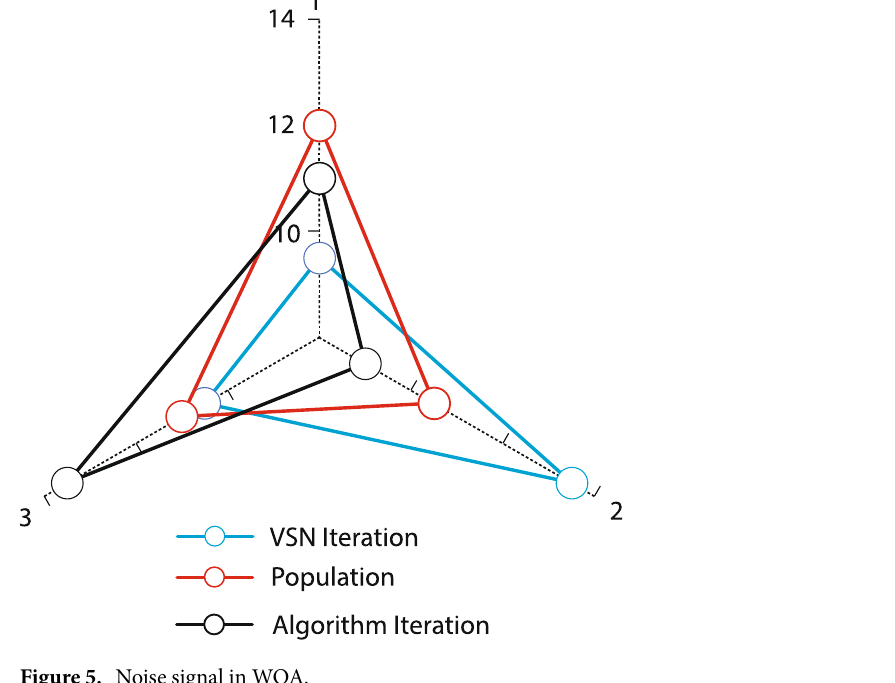
Figure 5. Noise signal in